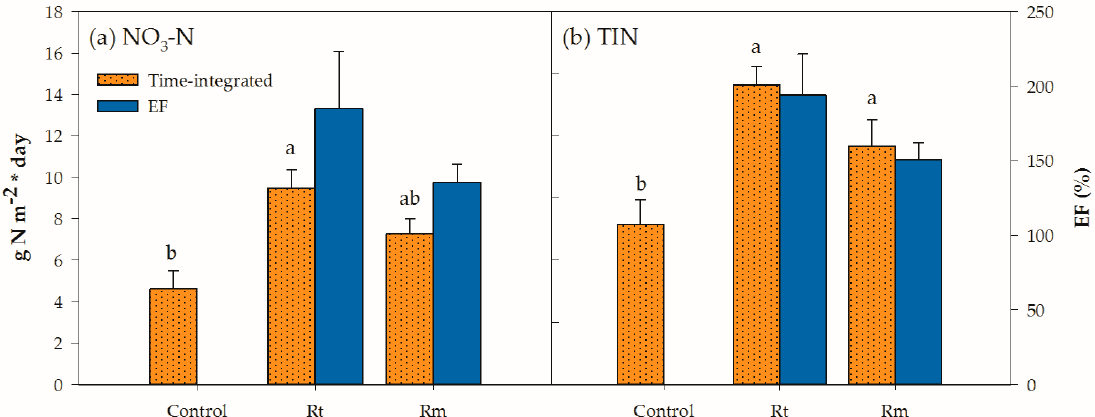
Figure 2. Time-integration (left axis) and enrichment factor (EF) (right axis) means and standard error for soil nitrogen variables by management system. ( a ) Soil NO 3 –N; ( b ) Soil TIN. Columns with the same letter are not significantly different at p ≤ 0.05.